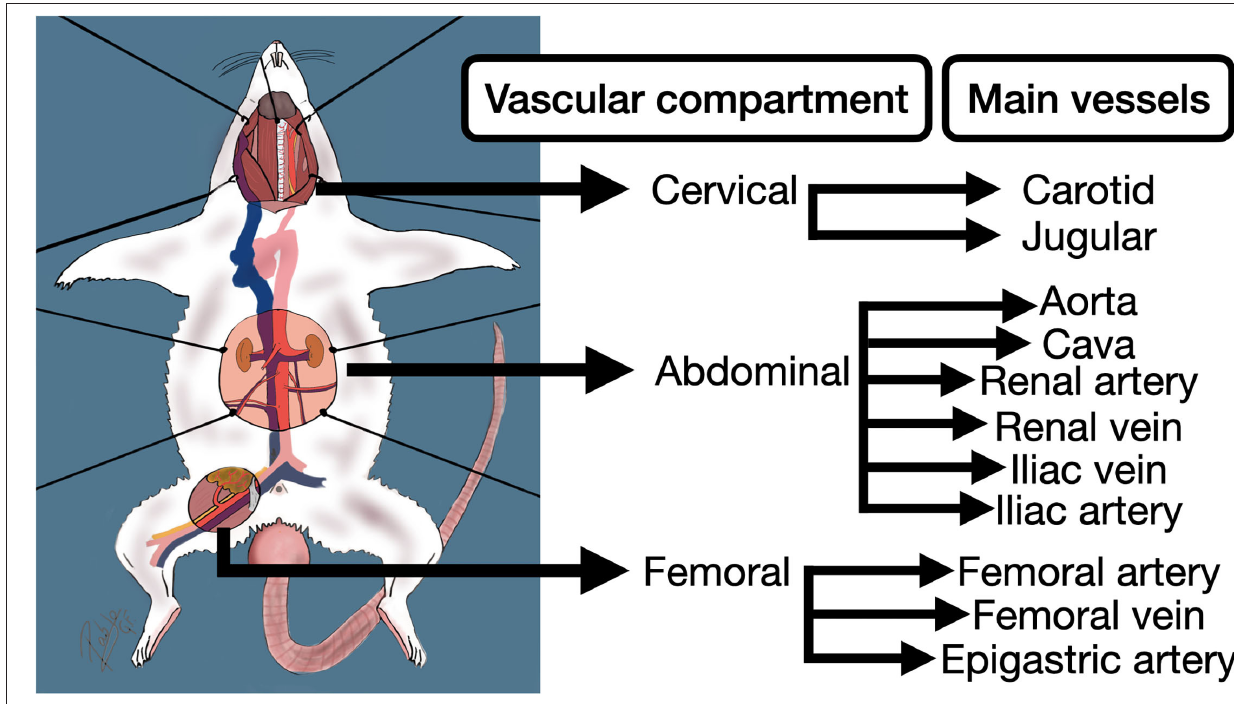
FIGURE 3 | Principal vascular compartments and vessels of the rodent for the practice of anastomoses in extracranial models for